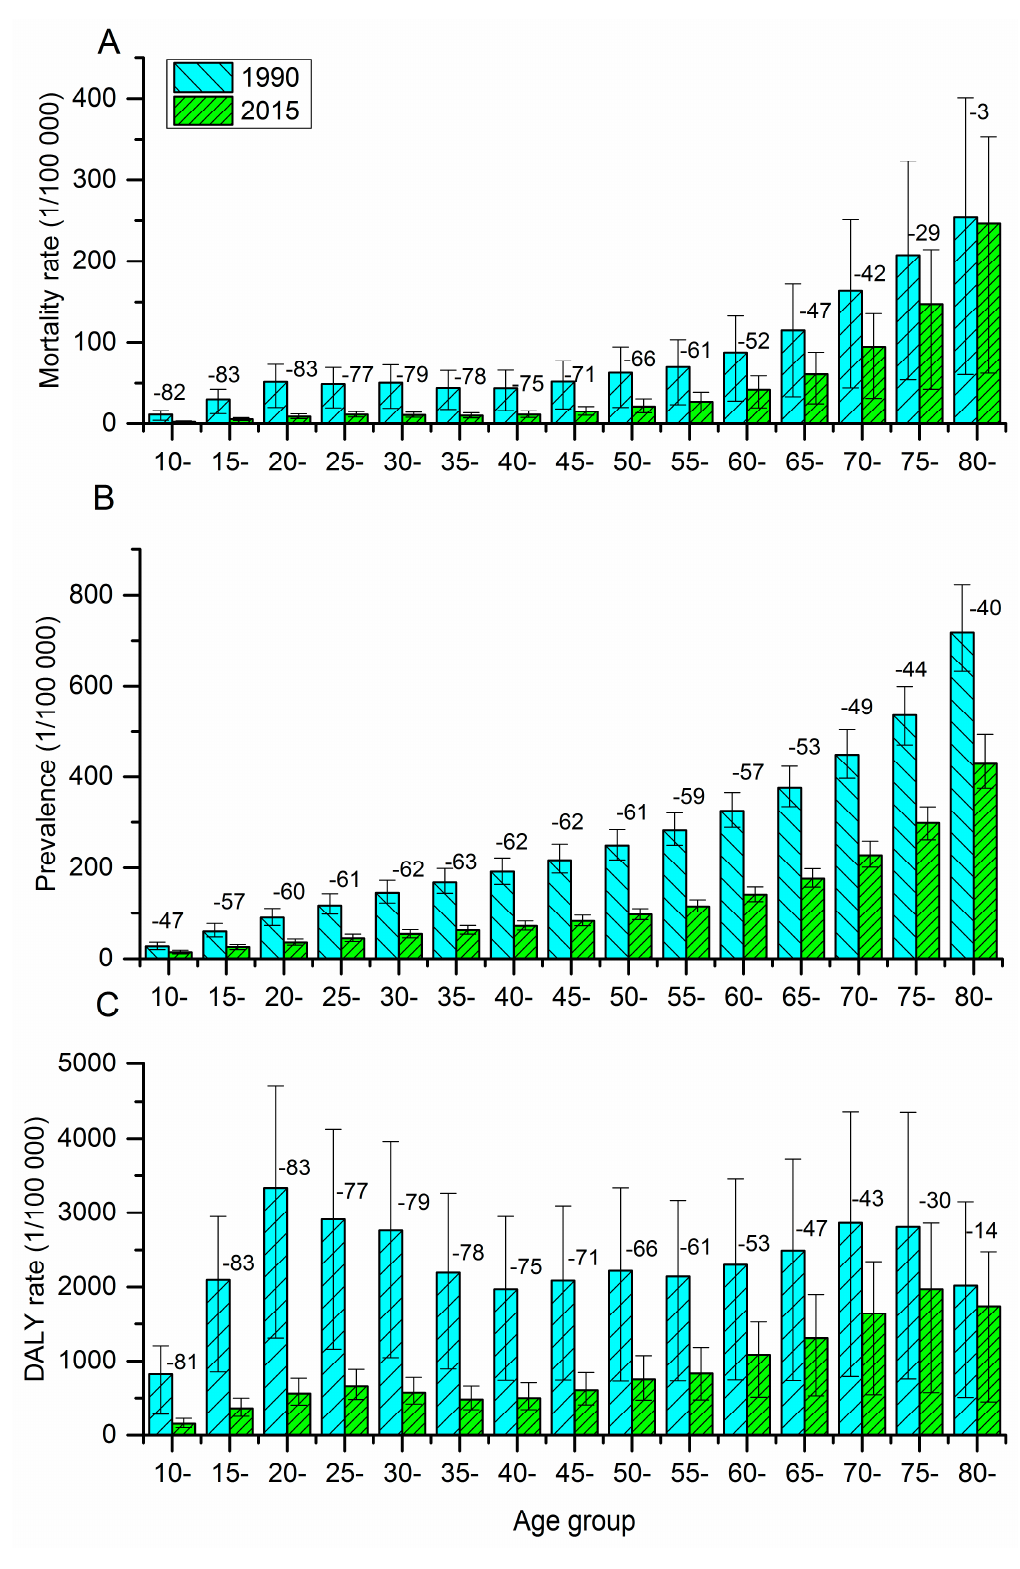
Figure 1. Mortality rates ( A ), prevalence ( B ), and DALYs rates ( C ) of self ‐ harm in 1990 and 2015 by 5 ‐ year age intervals. Error bars indicate 95% uncertainty intervals. (Numbers shown above bars are percentage change for each age group between 1990 and 2015. DALY = disability ‐ adjusted life ‐ years.)